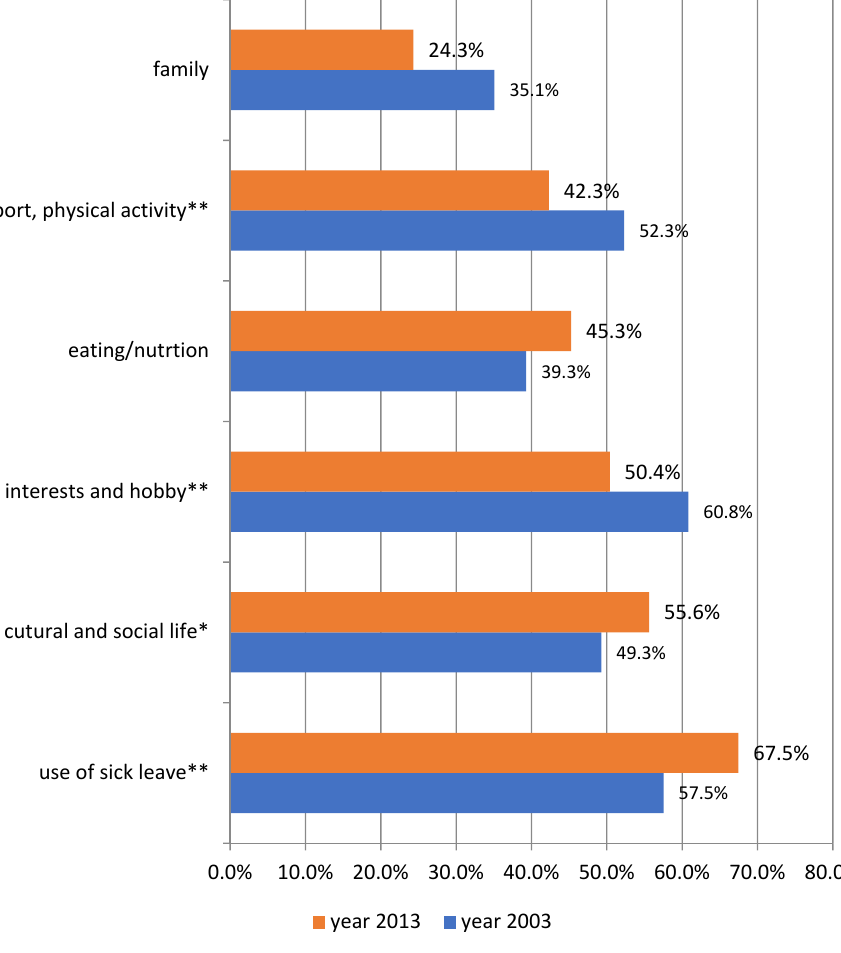
Figure 1. Declaration of lack of enough time to be active in selected spheres of life due to overloading by occupational work depending on the year of the survey (percentage of answers “I definitely agree” and “I rather agree” in the case of statements indicating lack of enough time for non-professional activities, and percentage of answers “I rather disagree” and “I strongly disagree” in the case of answers indicating that he or she always has enough time for non-professional activities). The significance of the differences between 2003 and 2013 was tested using the Chi-square test. * p ≤ 0.05; ** p ≤